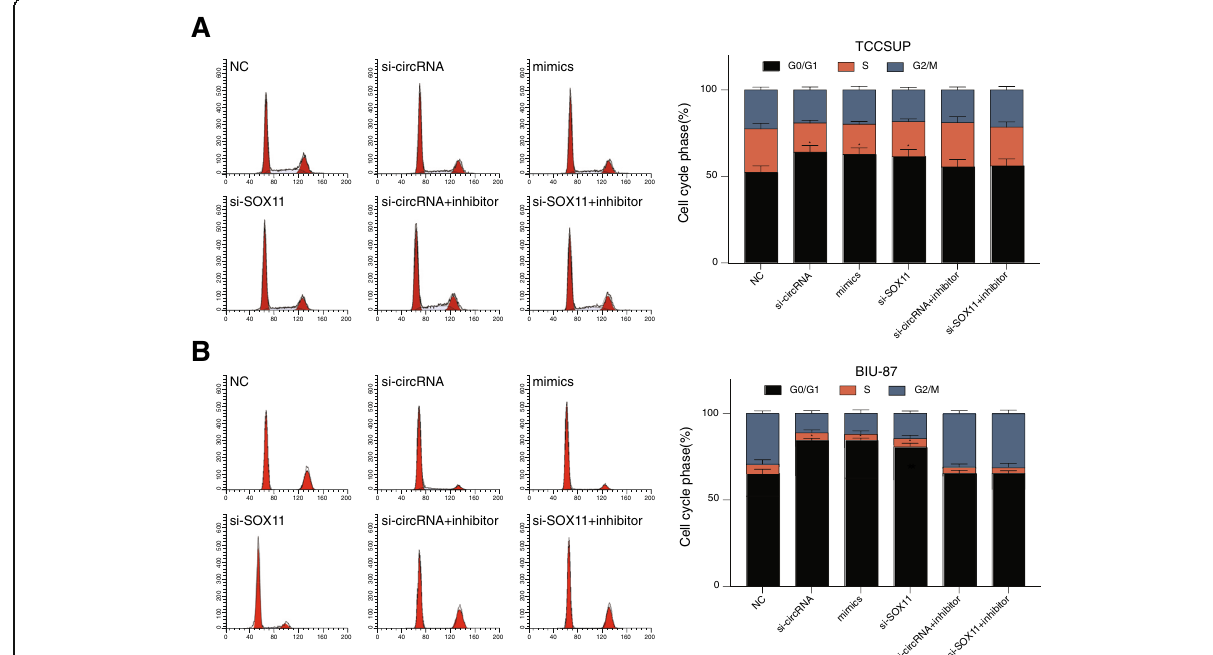
Fig. 7 Effects of circCEP128 on cell cycle. Cell cycle was analyzed using flow cytometry after transfection with si-circRNA of circCEP128, miR-145- 5p mimics, si- SOX11 , co-transfection with si-circRNA and the miR-145-5p inhibitor and co-transfection with si- SOX11 and the miR-145-5p inhibitor ( a ) in TCCSUP and ( b ) in BIU-87. Knockdown of circCEP128 induced G1/S arrest. * P < 0.05, compared with